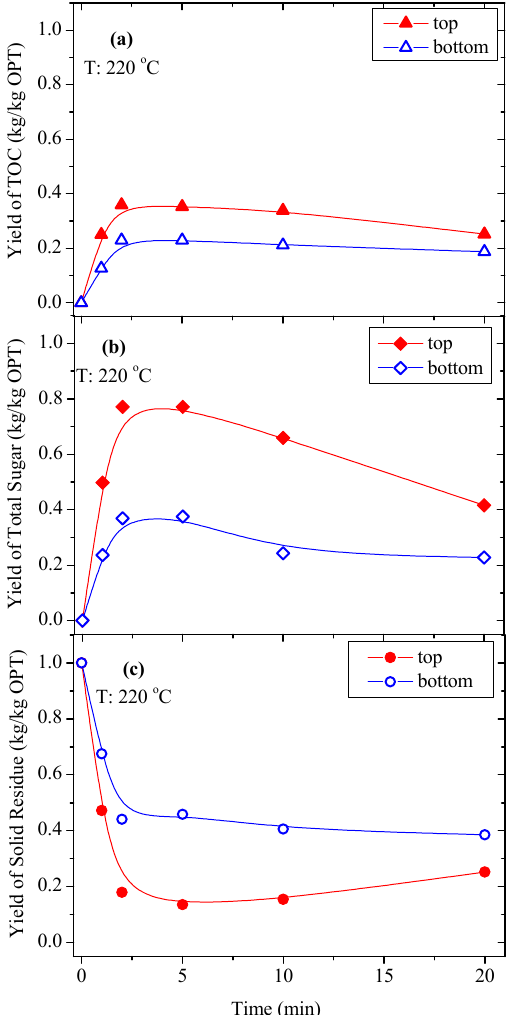
Figure 11. The e ff ect of the sub-CW treatment time over OPT21 on the yield of ( a ) TOC, ( b ) the total sugar and, and ( c ) the solid